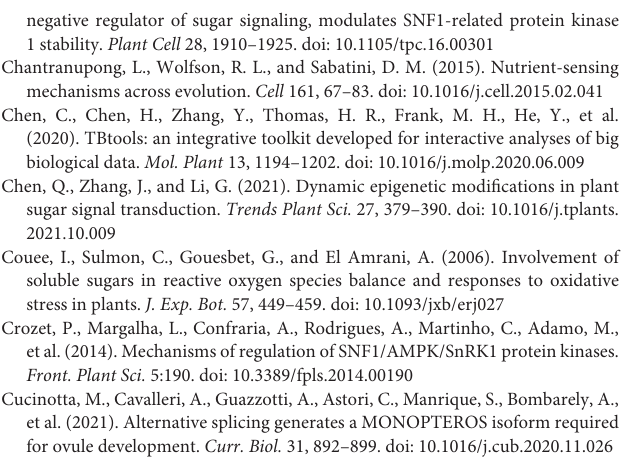
showing the overlap between DEGs and DSGs upon glucose stress. DEG_up, differentially upregulated genes (FC > 2, FDR < 0.01); DSGs, differential alternative splicing genes (| (cid:49) PSI| > 5%, p < 0.05); DEG_down, differentially down-regulated genes (FC < 1/2, FDR < 0.01). Supplementary Figure 4 | Identification of DSGs genes upon glucose stress. (A–E) Alternative splicing events of RNU1 , AT5G48220 , LUH , MED26B , and UGT76E4 in WT_Ctr and WT_Glc samples. The left panels shows the gene model, AS isoforms, and IGV coverage diagrams for each tested gene; the middle panel shows the transcription level of transcript variants for each tested gene; the right panel shows the confirmation results of AS events by RT-PCR with the primers shown as black arrows in the left panel. NT, novel transcripts. Supplementary Figure 5 | Glucose stress regulates the AS events of GRP s upon glucose stress. (A–E) Identification of AS events of GRP3S , GRP8 , GRP9 , CSP2 , and CSP4 in WT_Ctr and WT_Glc samples. The left panels showed the gene model and IGV coverage diagrams for each tested gene, the yellow bars represent the mRNA region encoding glycine-rich (GR) domain; the right panel showed the confirmation results of AS events by RT-PCR with the primers shown as black arrows in the left panels. Supplementary Figure 6 | Glucose stress regulates the AS events of GRP s and RS31 via TOR-ROS pathway upon glucose stress. Working model for the AS regulation upon glucose stress. High sugar inhibits the photosynthesis and promotes the glycolysis-mitochondria function; both the photosynthetic sugars and external high sugars are transmitted to mitochondria relay, further leading to the activation of TOR kinase; TOR kinase promotes the accumulation of ROS, such as H 2 O 2 , which results in the increase of productive transcript variants of GRP s and the decrease of unproductive transcript variants of RS31 , consequently affecting the downstream AS-associated transcriptional regulation. Supplementary Figure 7 | The biomass of the whole 7-day-old seedlings upon glucose treatment in different concentrations. The weight of wild type Arabidopsis 7-day-old seedlings grown upon glucose treatment in different concentration of 0 (Ctr), 1, 2, and 3%, respectively, were measured and the average weight of each seedling were compared. Supplementary Figure 8 | The overlapping analysis of differential alternative splicing (DAS) genes induced by high glucose treatment, by loss of function of GRP7 in grp7-1 8i , and GRP7 target genes identified by RIP/iCLIP. (A) Venn diagram showing an overlap between DSGs regulated by high glucose treatment, target genes of GRP7 identified by RIP/iCLIP and DSGs controlled by grp7 8i . (B,C) AS events of LAF3 and AT5G51620 in WT_Ctr and WT_Glc samples. The left panels show the gene model, AS isoforms, and IGV coverage diagrams for each tested gene; the right panel shows the confirmation results of AS events by RT-PCR with the primers shown as black arrows in the left panels. NT, novel